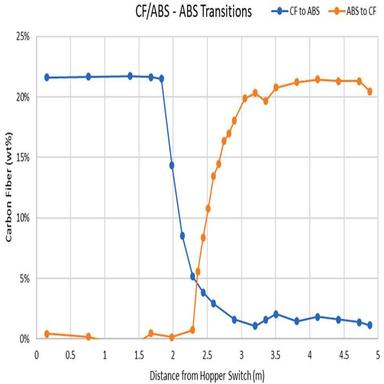
A combination of both transition curves that more easily demonstrates their differences in transition behavior. The singular dip below 0 wt% was less than 1 wt%, so it was attributed to the error inherent to the CIN process, as shown in.